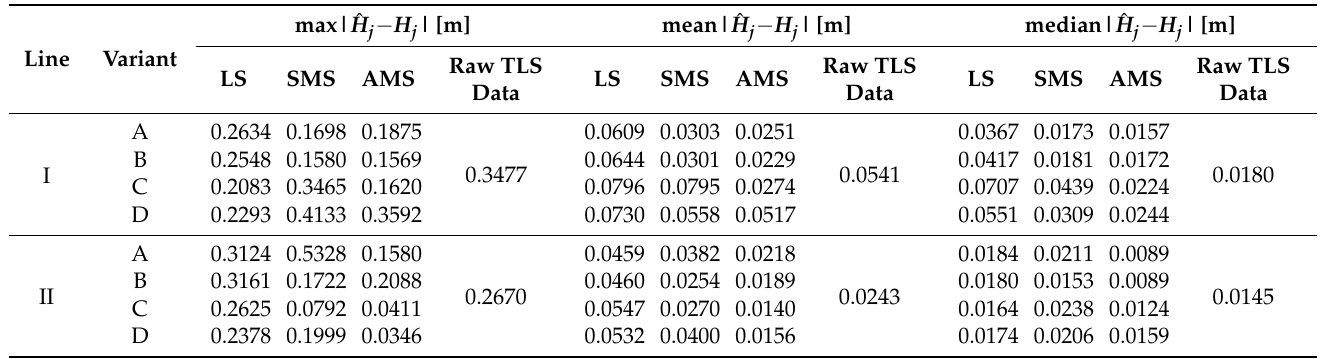
Table 2. Maximum, mean and median of ˆ